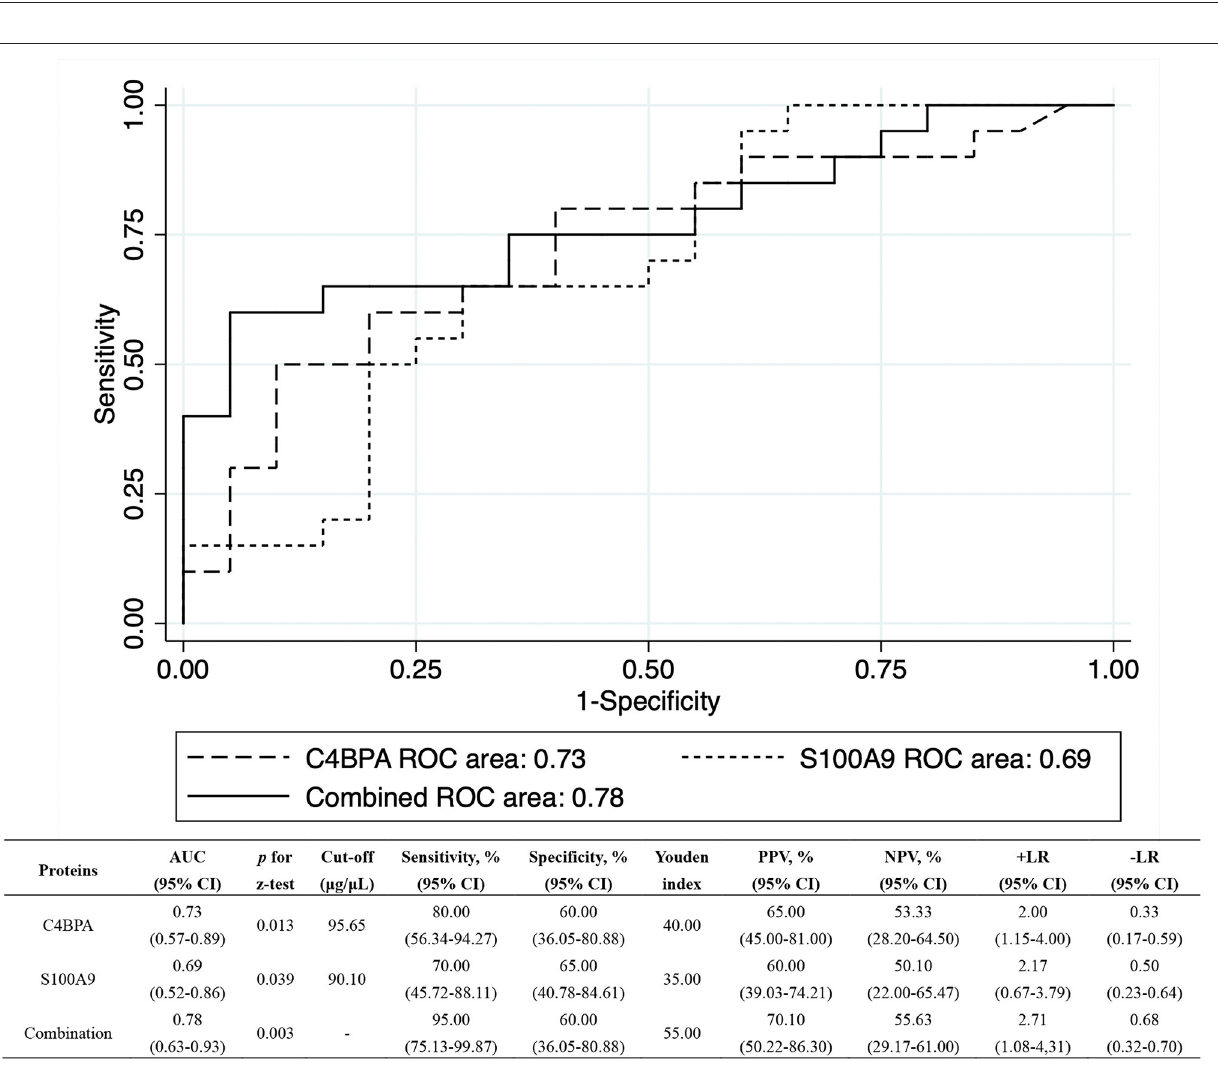
FIGURE 3 | The ROC analysis for C4BPA and S100A9 using proteomic set. The ROC analyses were performed for baseline levels of C4BPA and S100A9 among the QFT reversion group, respectively. Their respective AUCs were 0.73 (95% CI: 0.57–0.89) and 0.69 (95% CI: 0.52–0.86). The combined AUC of C4BPA and S100A9 increased to 0.78 (95% CI: 0.63–0.93). AUC, area under ROC curve; CI, confidence interval; + LR, positive likelihood ratio; –LR, negative likelihood ratio; NPV, negative predictive value; PPV, positive predictive value; QFT, QuantiFERON-TB Gold In-Tube; ROC, receiver operating